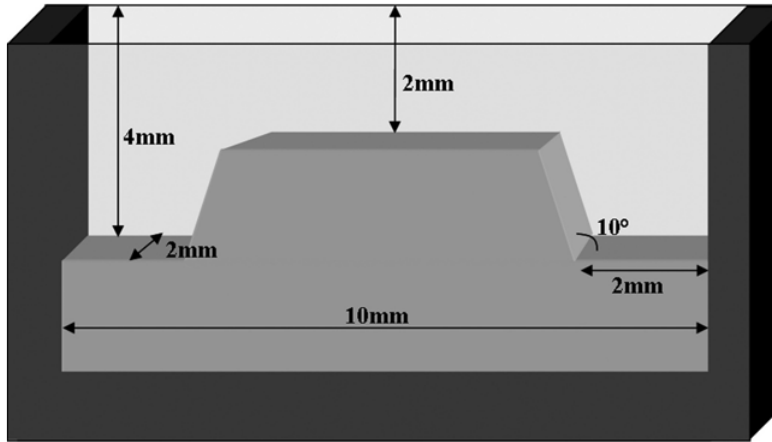
FIGURE 2- Dimensions and shape of the standard inlay cavity